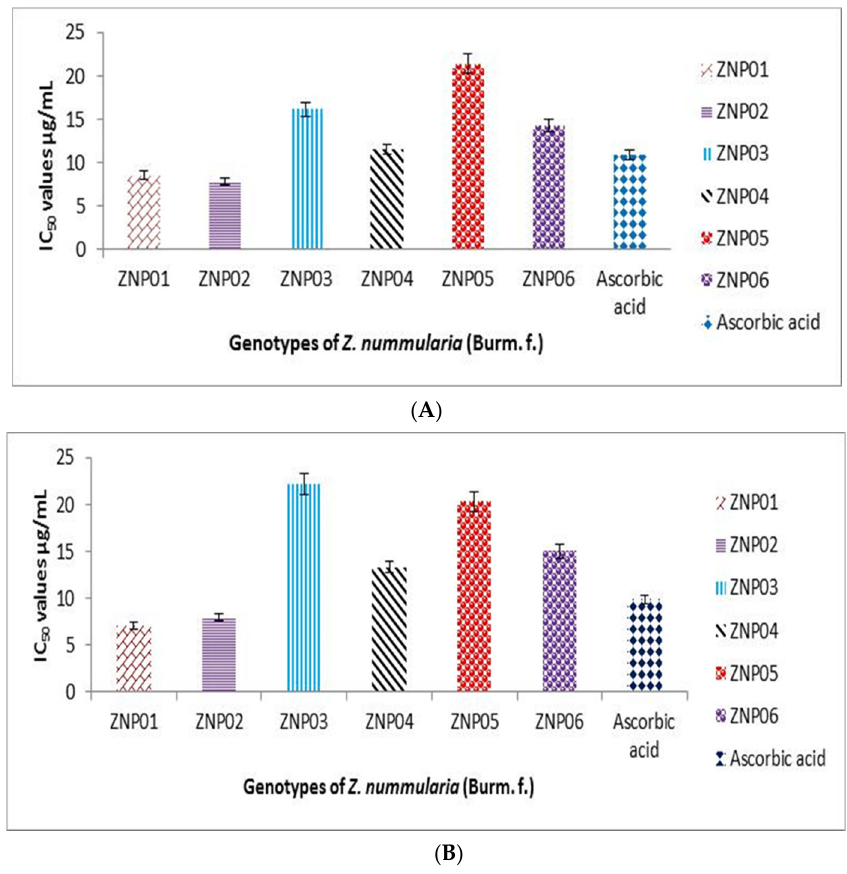
Figure 1. IC 50 values of six different genotypes of Z. nummularia against DPPH ( A ) and ABTS ( B ).